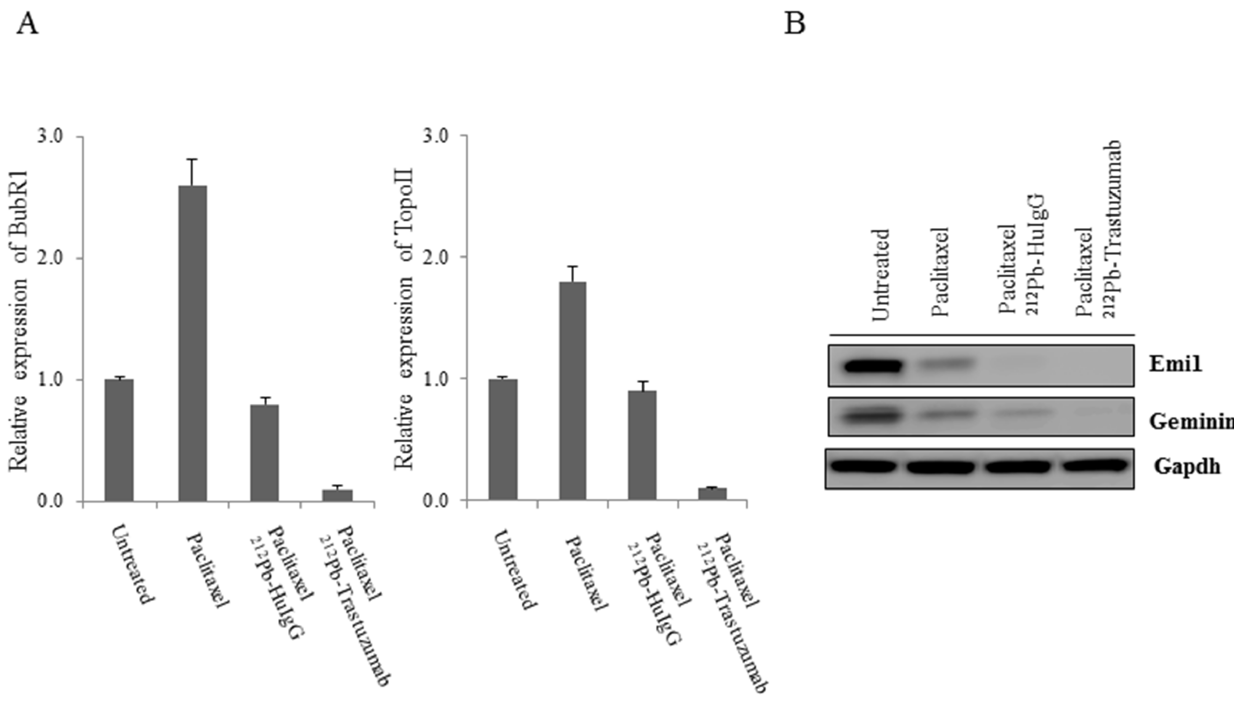
Figure 2. Pac/ 212 Pb-trastuzumab may induce chromosomal instability as a result of suppression of BUBR1 and EMI1 expression. Mice bearing i.p. LS-174T xenografts were treated by Pac/ 212 Pb-trastuzumab for 24 h. A. Expression of BUBR1 and TOPOII was determined by RT-PCR using specific primers for BUBR1 and TOPOISOMERASE II . Results represent the average of a minimum of three replications. B. Immunoblot analysis for EMI1 and GEMININ was performed with tumor tissue collected 24 h after Pac/ 212 Pb- trastuzumab treatment. The EMI1 and GEMININ were detected at 56 kDa and 35 kDa, respectively. Equal protein loading control was GAPDH.